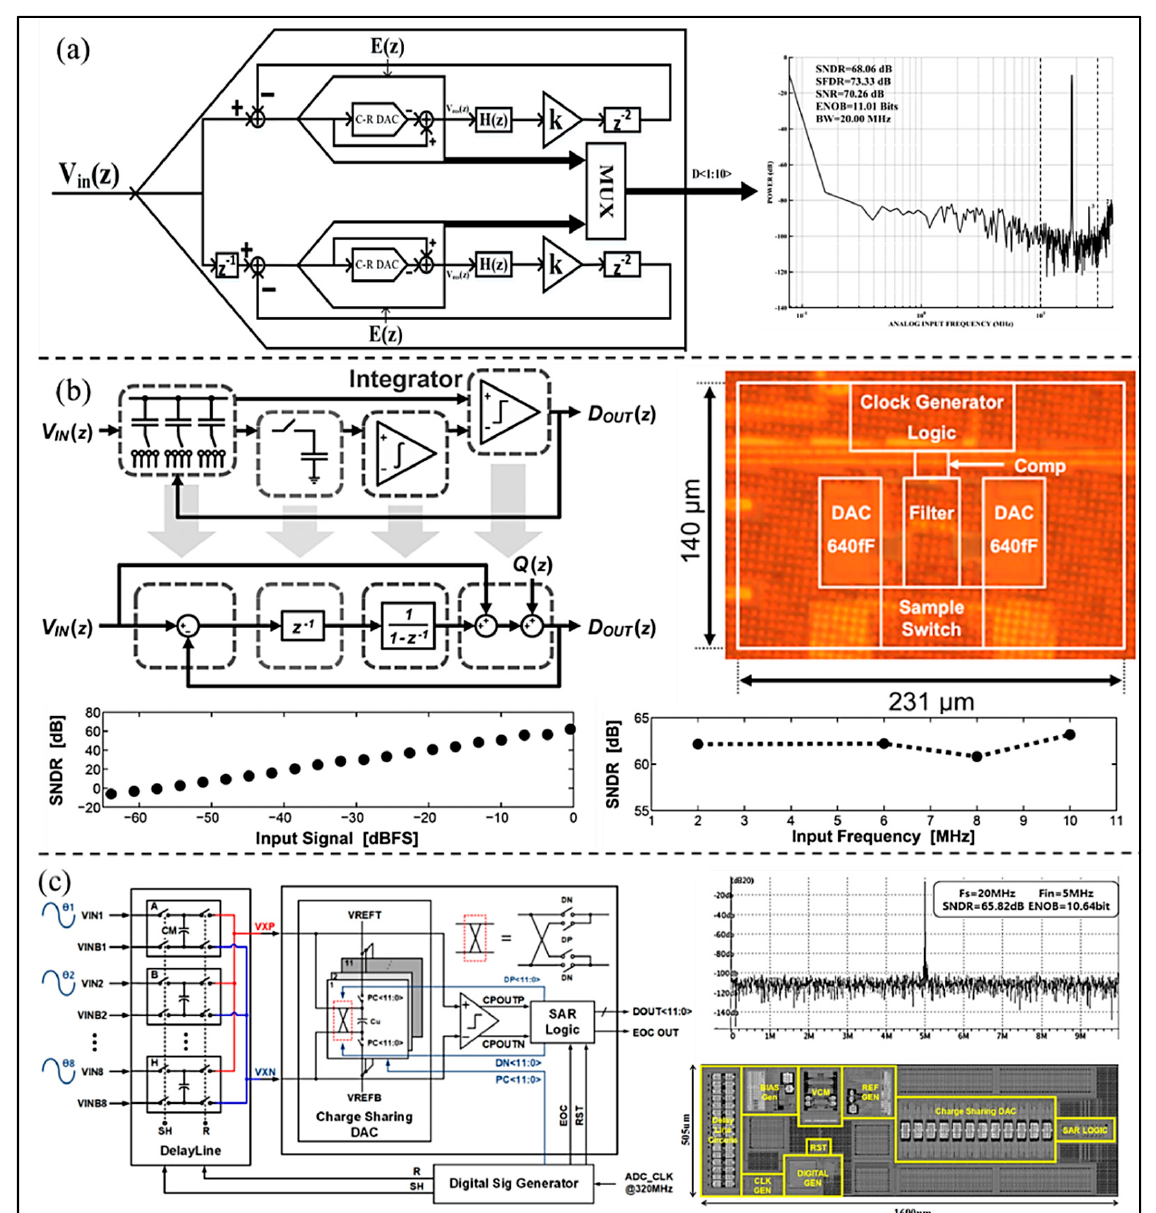
Figure 5. ( a ) Basic structure and simulation spectrum of proposed band-pass noise-shaping ADC. (Reprinted from [38], Copyright 2019, with permission from IEEE); ( b ) Circuit structure, measured performance, and die photograph of the proposed ADC. (Reprinted from [39], Copyright 2012, with permission from IEEE); ( c ) Block Diagram, simulation results, and layout of the proposed SAR ADC. (Reprinted from [40], Copyright 2021, with permission from IEEE).